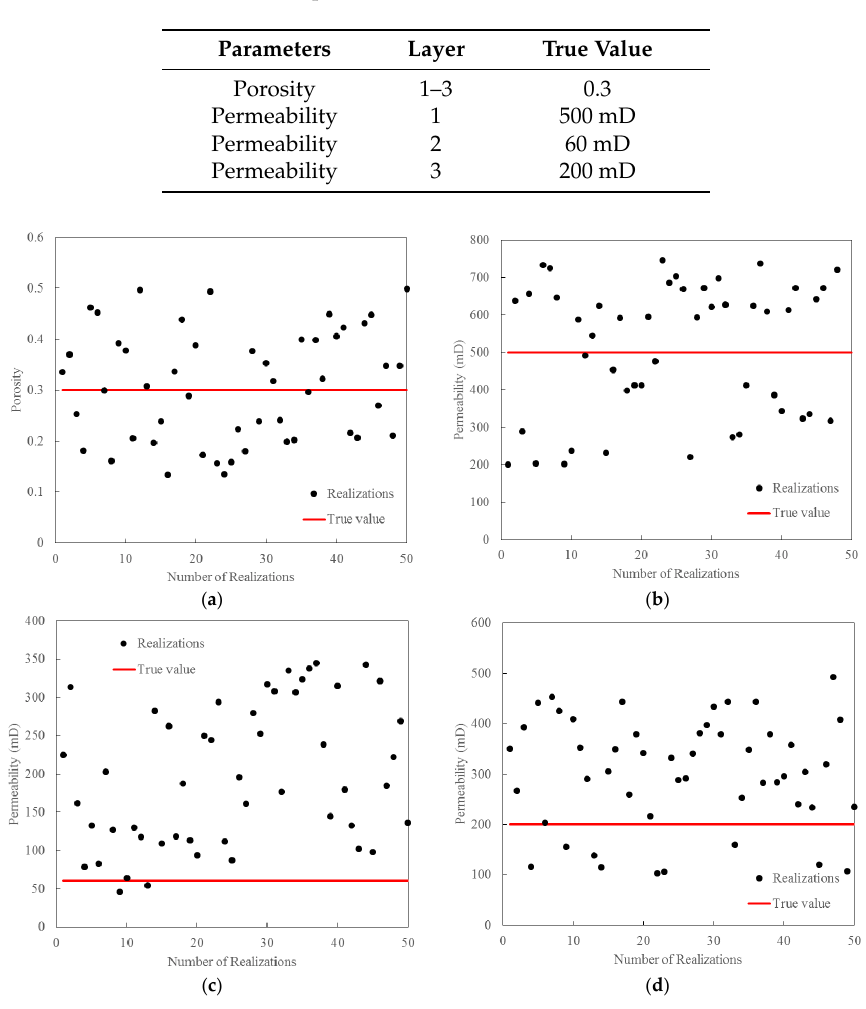
Figure 9. The parameter values before history matching: ( a ) Porosity; ( b ) Permeability in layer 1; ( c ) Permeability in layer 2; and ( d ) Permeability in layer 3.